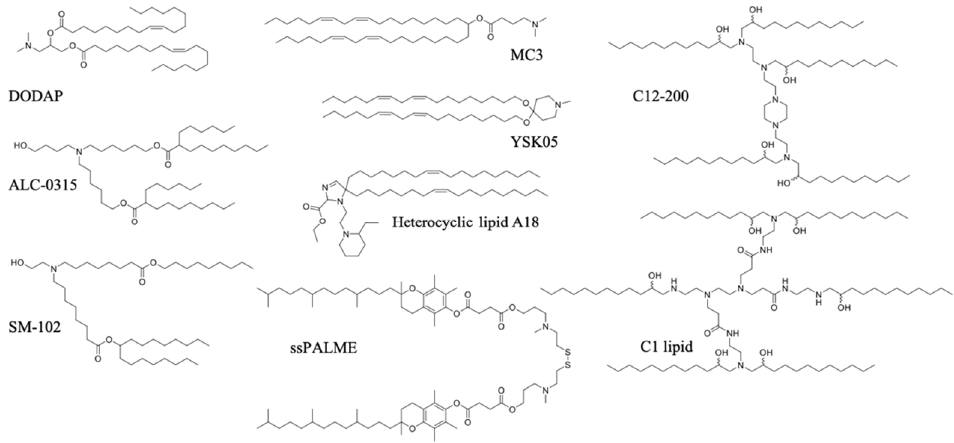
Figure 4. Ionizable lipids used in pDNA/mRNA